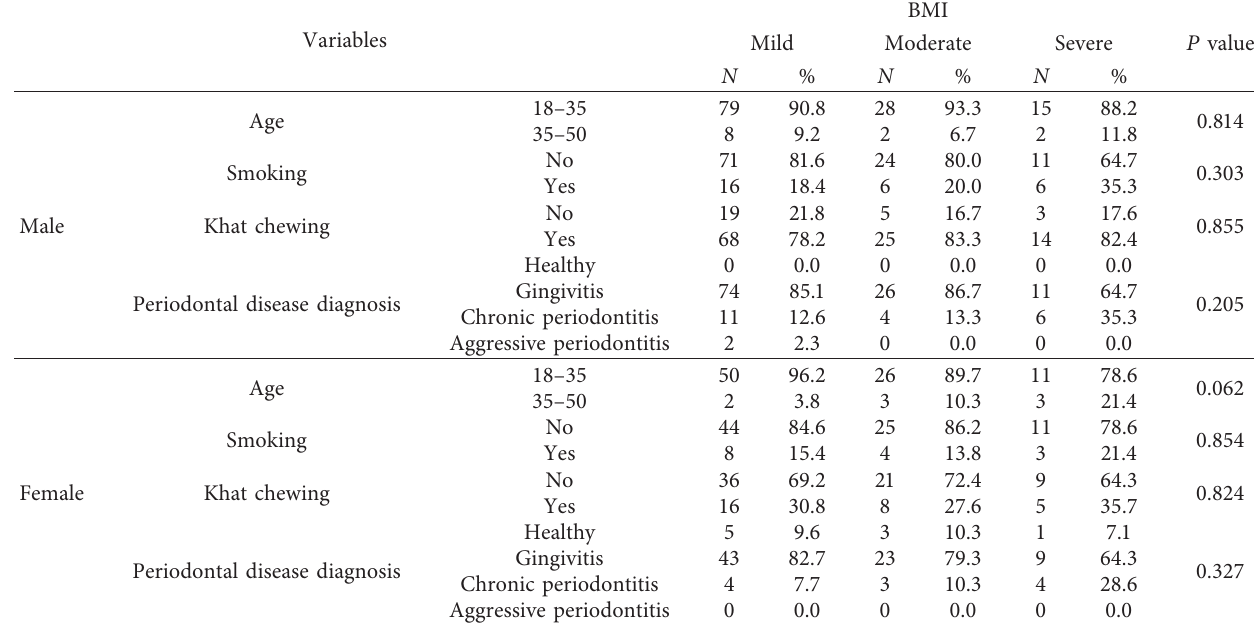
Table 4: Distribution of body mass index with age, smoking, khat chewing, and PDs categorized by